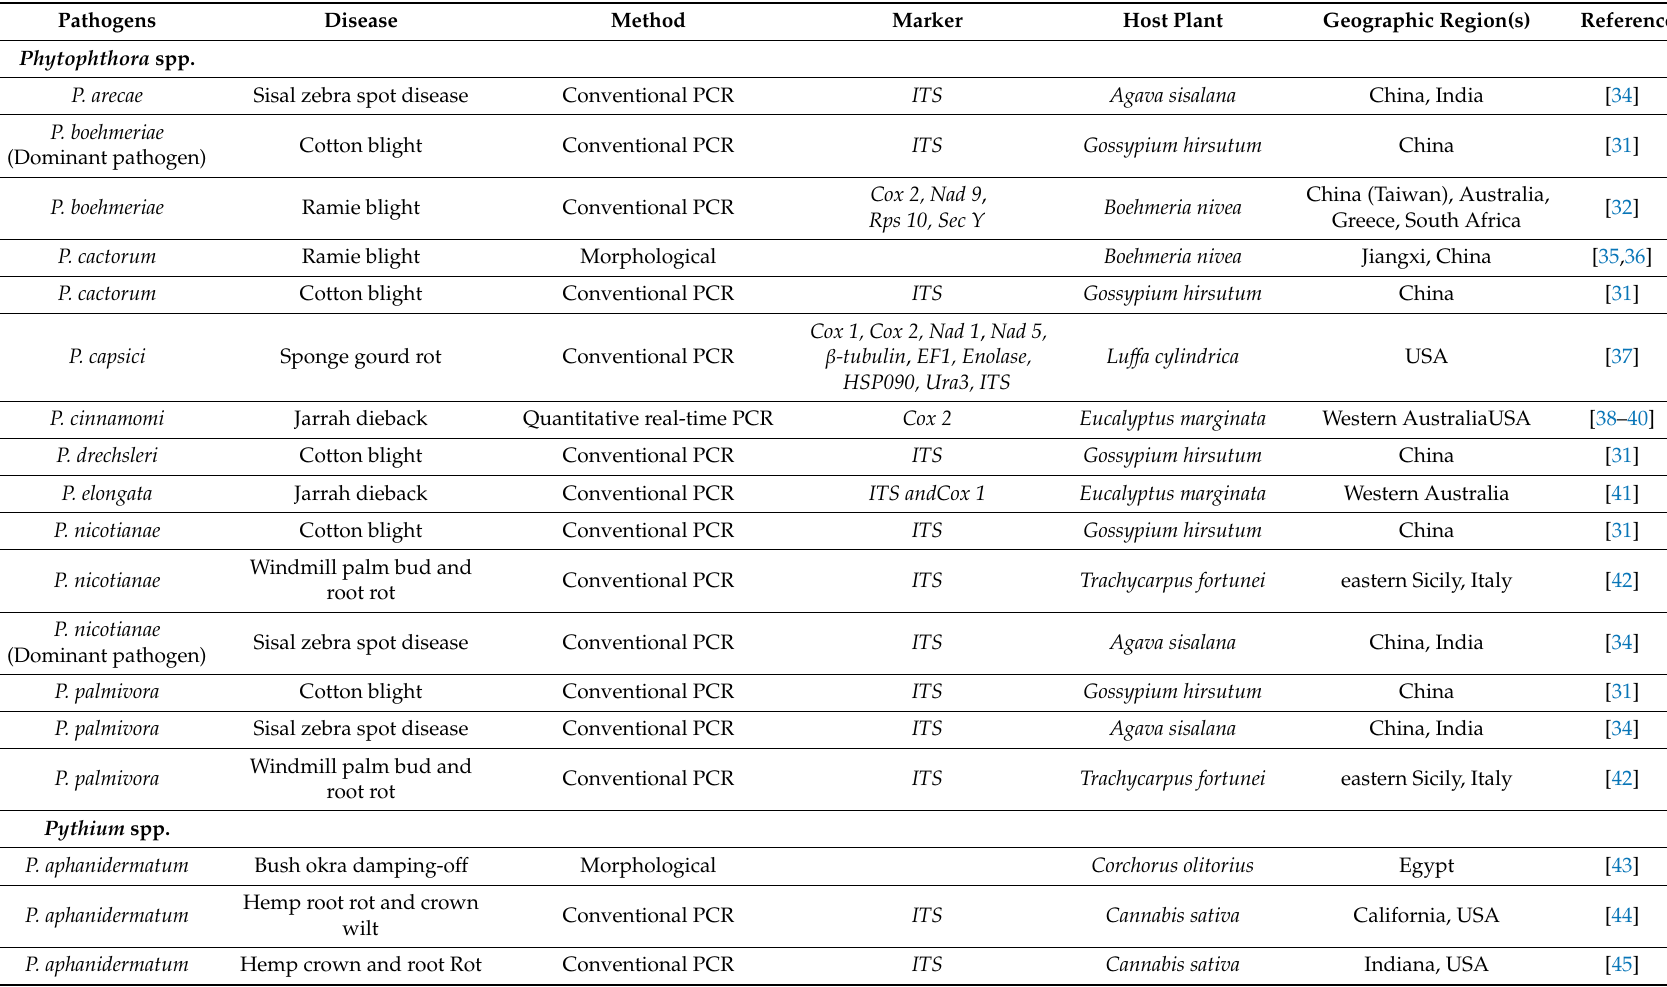
Table 2. Diseases of oomycetes on main fiber crops and identification